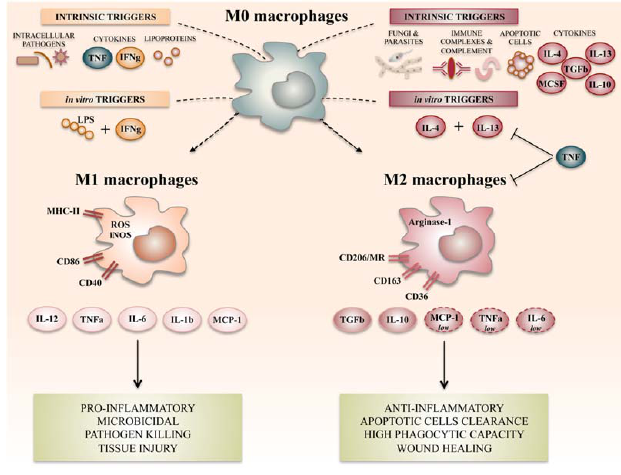
Figure 1. Summary of the main macrophage polarization states of activated macrophages. Different stimuli and signaling pathways have been described as inducers of M1 ‐ like or M2 ‐ like activation